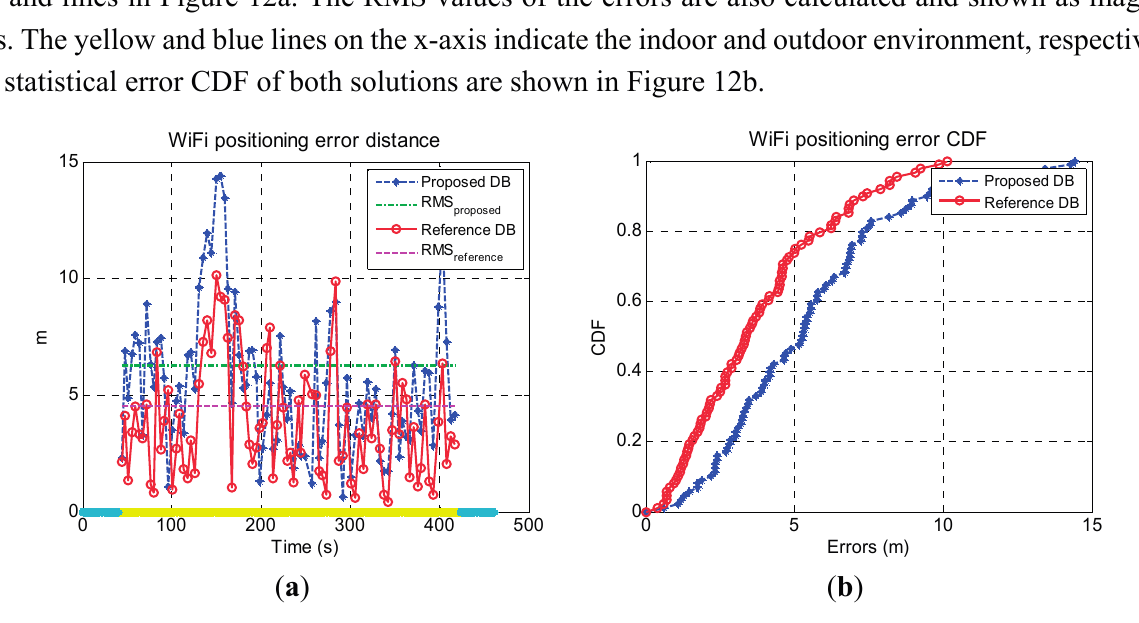
Figure 12. Time series of WiFi fingerprinting errors ( a ) and corresponding CDF ( b